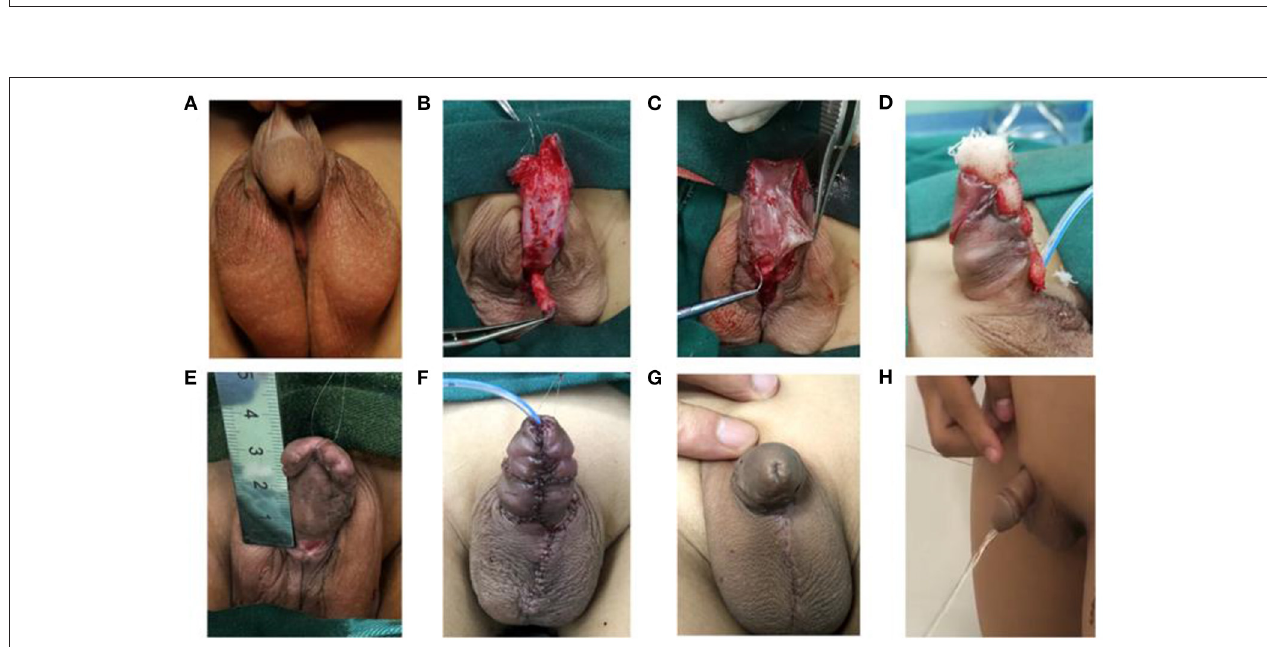
FIGURE 2 | Schematic plot for pre-implanted urethral plate staged surgery. (A) Appearance before the first-stage surgery; (B) The urethra is freed and the penis is straightened; (C) The freed skin flap is sutured at multiple points for fixation; (D) Vaseline gauze is used between the sutures; (E) Appearance before the second stage of the surgery; (F) Appearance after sutures in the second stage of surgery; (G) Appearance after the second surgery; (H) Urination after the second surgery.